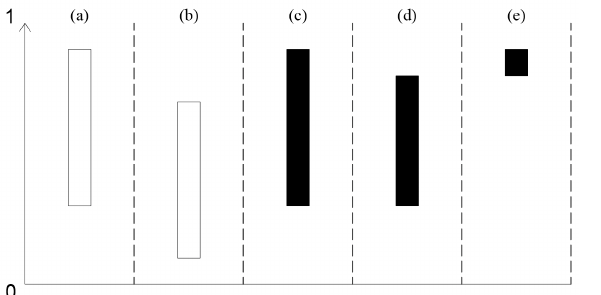
Figure 13. Candlesticks used for comparison of IFS generalizations. ( a ) (cid:104) µ A , ν A (cid:105) = (cid:104) 0.3,0.1 (cid:105) ( b ) (cid:104) µ A , ν A (cid:105) = (cid:104) 0.1,0.3 (cid:105) ( c ) (cid:104) µ A , ν A (cid:105) = (cid:104) 0.9,0.7 (cid:105) ( d ) (cid:104) µ A , ν A (cid:105) = (cid:104) 0.8,0.7 (cid:105) ( e ) (cid:104) µ A , ν A (cid:105) = (cid:104) 0.9,0.2 (cid:105) .